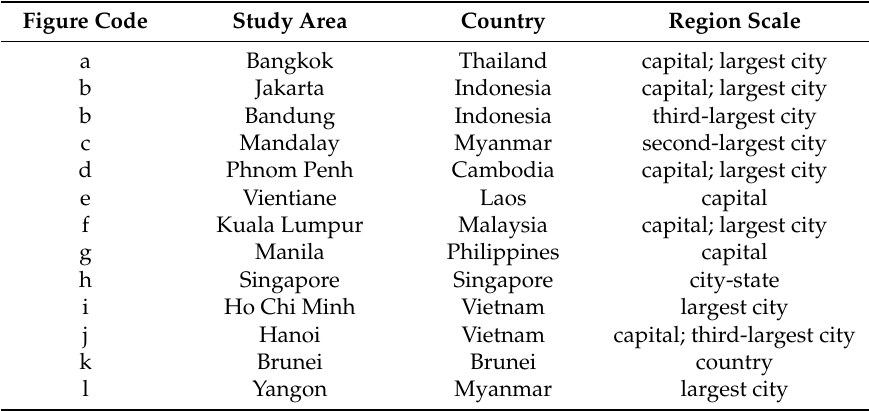
Table 4. Locations and attribute information of the areas shown in Figure 8. Figure Code Study